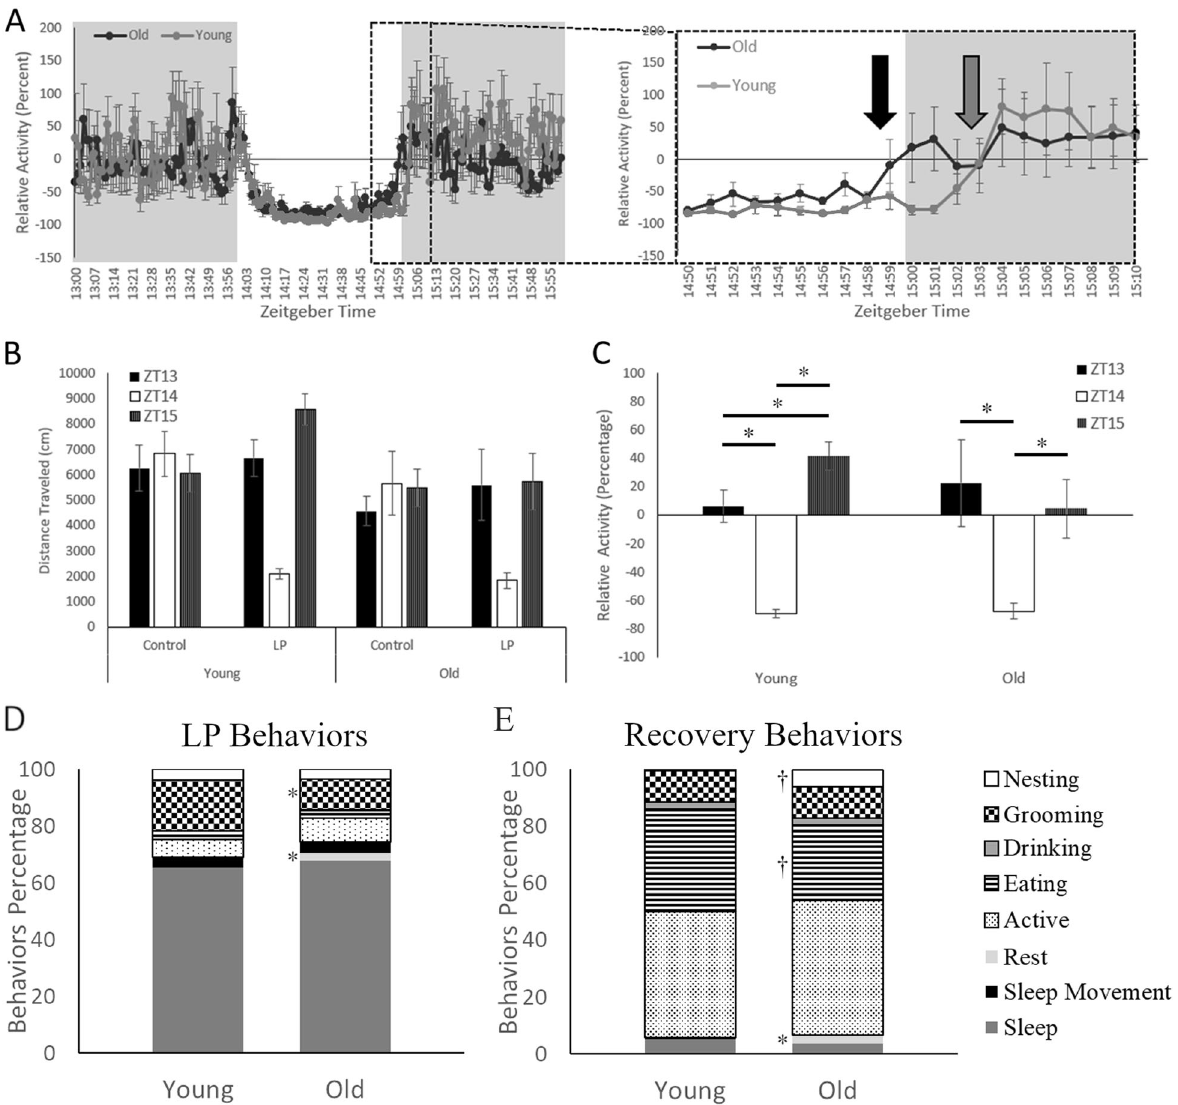
Fig. 4 The masking effects of nighttime light exposure given at ZT14 between the age groups. A A plot of before, during, and after the masking pulse spanning three hours of activity in one-minute bins (Left Panel). The gray area indicates the hours before and after the light pulse (LP), while the white indicates light exposure. The inlet highlights the transition period 10 min before and after the return to darkness as animals return to baseline activity levels (Right Panel). Young animals in light gray recover from the LP after being returned to darkness (Gray Arrow) while the older animals in black do not sustain activity the entirety of the LP (Black Arrow). B Activity for animals plotted at the hour level on a control day, where no LP is given, did not differ across the 3 h between either young or old animals. However, both ages had dramatic differences in activity levels on the LP day. C Statistical comparisons of activity levels, corrected to control day levels as a relative percentage, indicate signi fi cant suppression of activity during LP and heightened recovery levels in young mice at ZT15. D and E